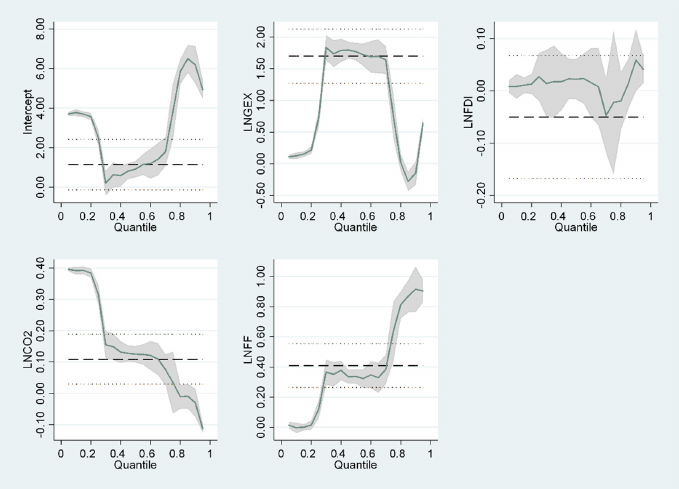
Figure 3. PQR-North.